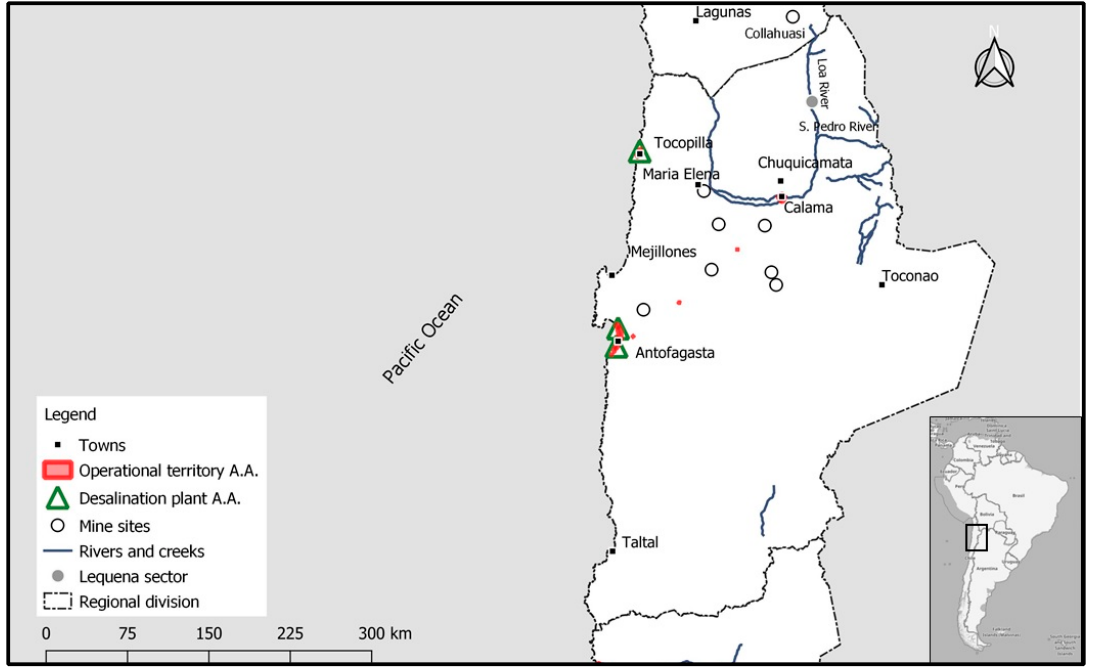
Figure 1. Aguas Antofagasta and mining companies involved in water contracts.